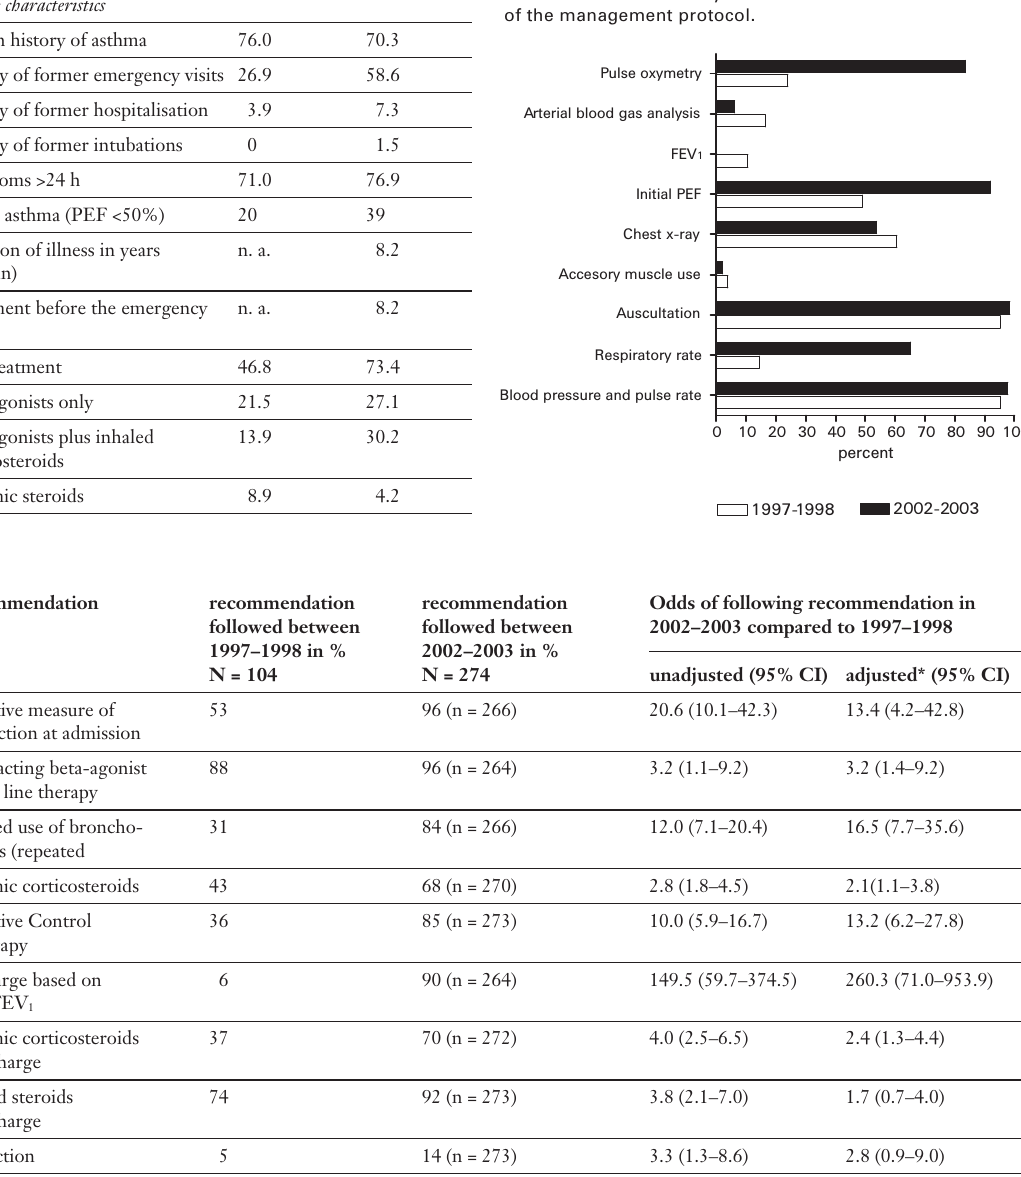
Clinical assessment, chest x-ray and objective measure- ments of asthma severity before and after the introduction of the management